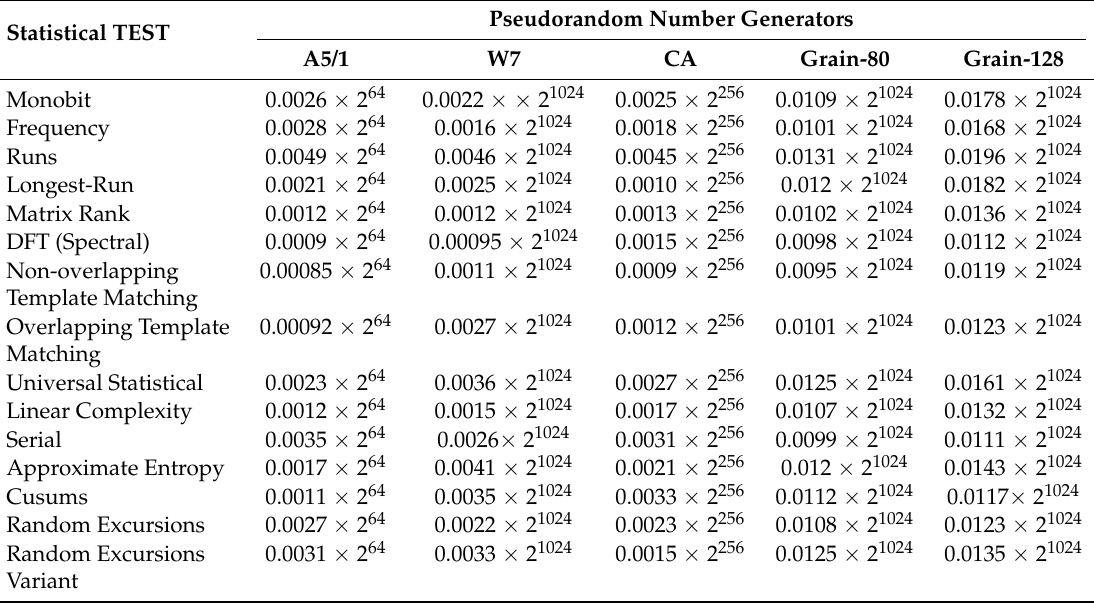
Table 5. Statistical Test Analyses for Pseudorandom Number Generators.